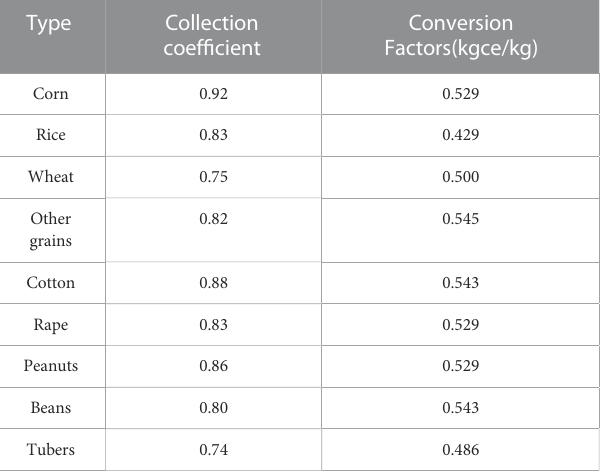
TABLE 3 Crop straw collection coef fi cient and conversion